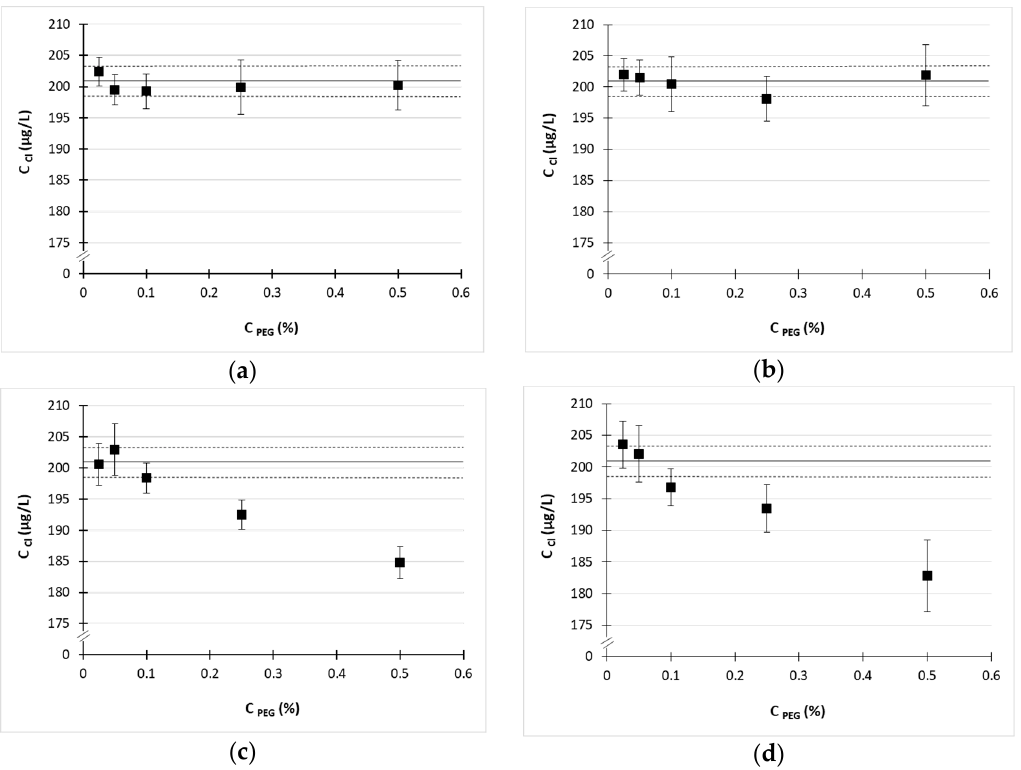
Figure 1. Results of the determination of chlorine in chloride spiked (200 µg/L) polyethylene glycols (PEGs) solutions: ( a ) PEG-600; ( b ) PEG-2000; ( c ) PEG-10000; ( d ) PEG-20000.